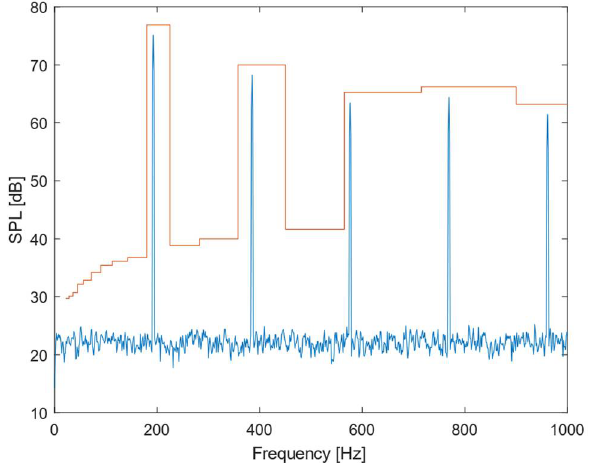
Figure 11. Simulation of the sound pressure level measured at 0.5 m from the outlet of a 3 m long straight pipe.